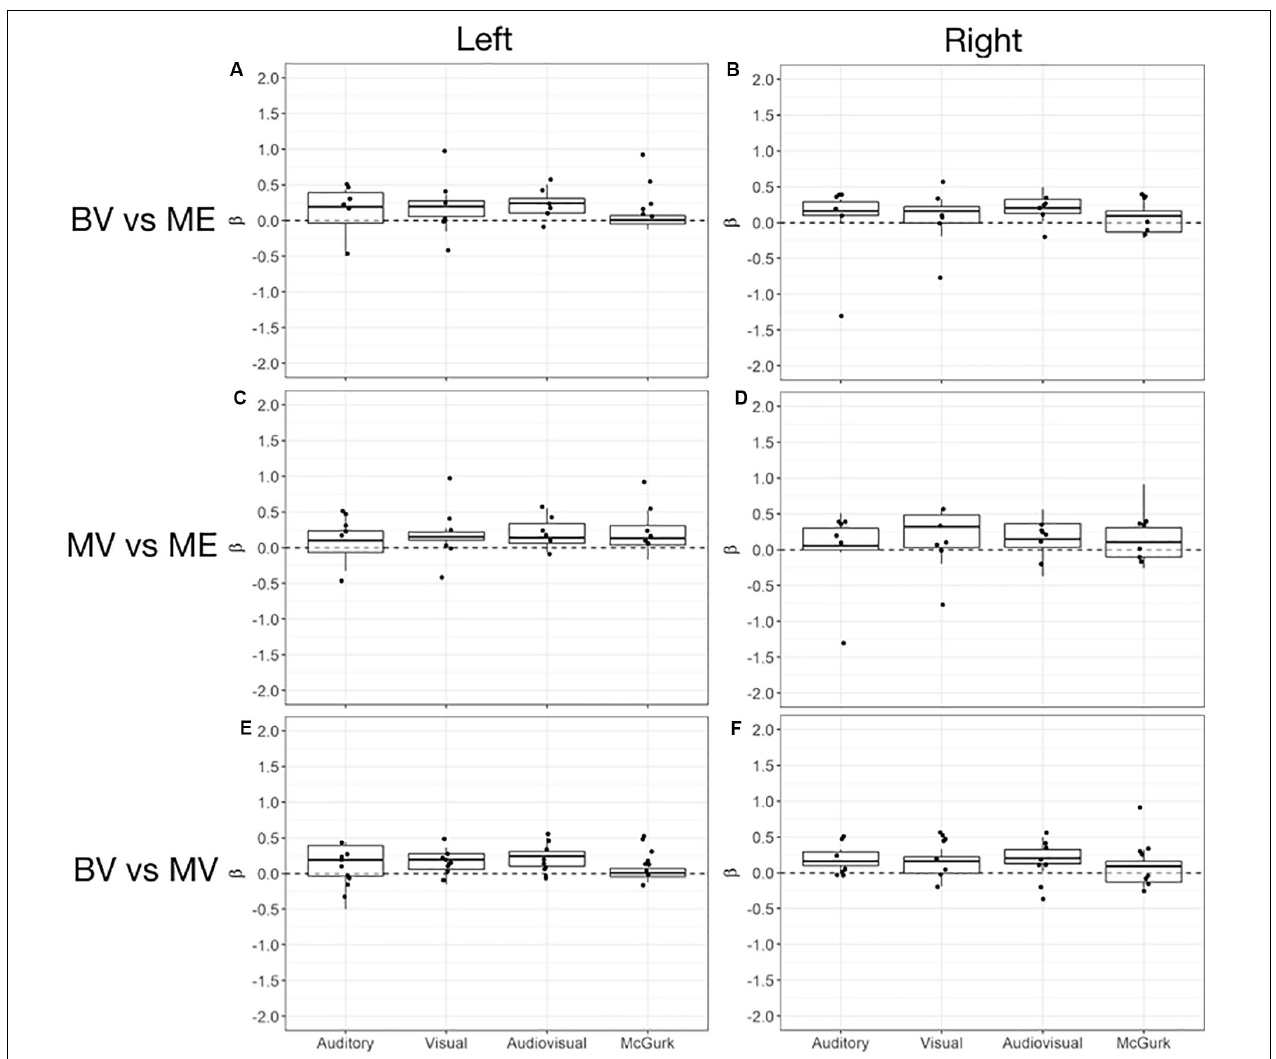
FIGURE 5 | Box and whisker plots of the distribution of peak beta weights for the auditory, visual, audiovisual and McGurk stimulus conditions for the left audiovisual ROI [BV group = (A,E) ; MV group = (C) ] and right audiovisual ROI [BV group = (B,F) ; MV group = (D) ]. The horizontal line within each box represents the median. The boxes correspond to the 25th and 75th percentiles, the whiskers correspond to the 5th and 95th percentiles. Individual data points for ME group are plotted (A–D) and MV group (E,F)